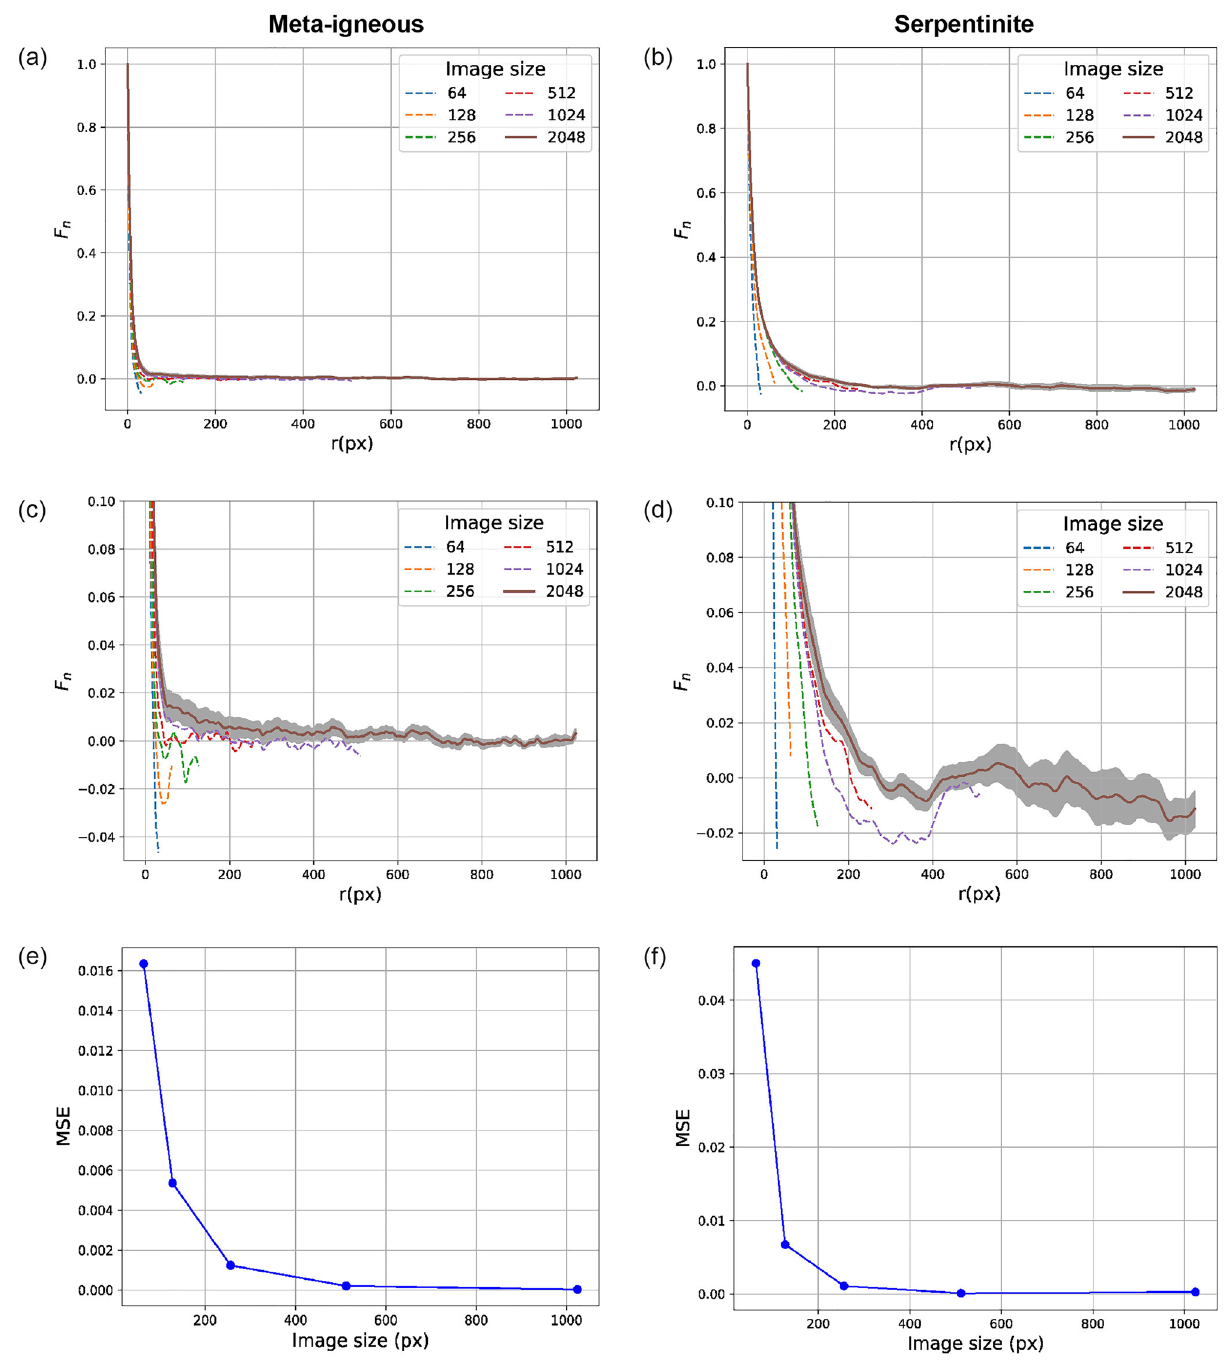
Figure 5. RES analysis by scaled autocovariance function F n (Eq. 2) calculated for images of different sizes. ( a , b ) Are F n functions computed for the meta-igneous rock and serpentinite samples, respectively, where ( c , d ) show the magnified views of ( a , d ). Grey shadow indicates the 95 percent confidence levels around the average 2 values of the largest image ( 2048 pixels). ( e , f ) MSEs are calculated between the average F n of the largest image and smaller